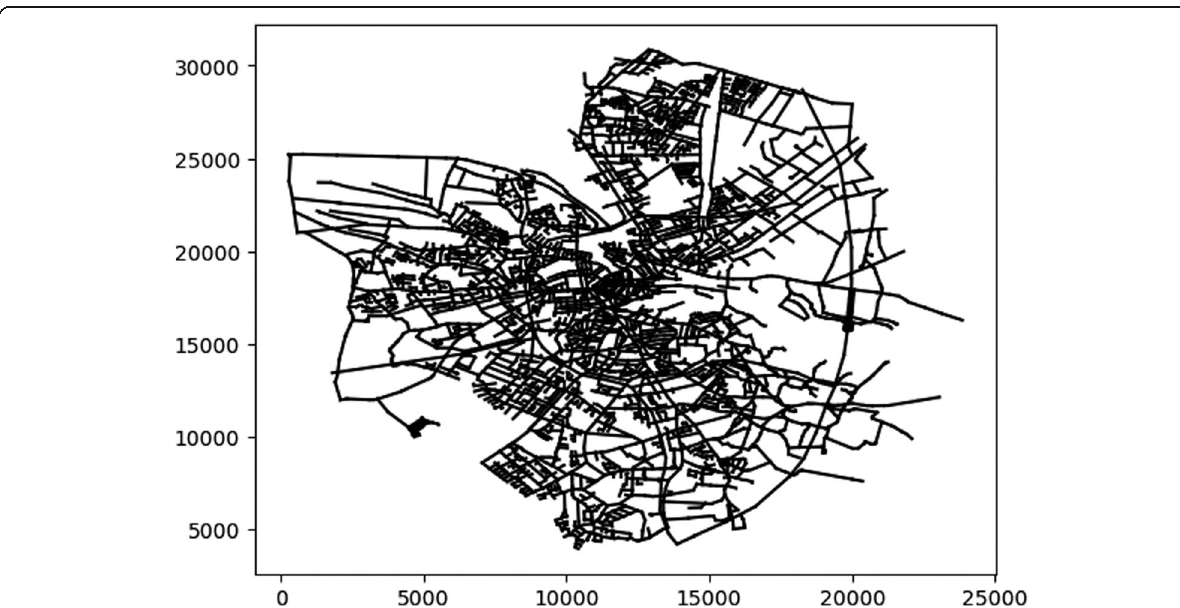
Fig. 7 The city road network of Oldenburg, Germany generated from raw data. As shown in this figure, the Oldenburg ’ s real road network generated from the roads and vertices in the original